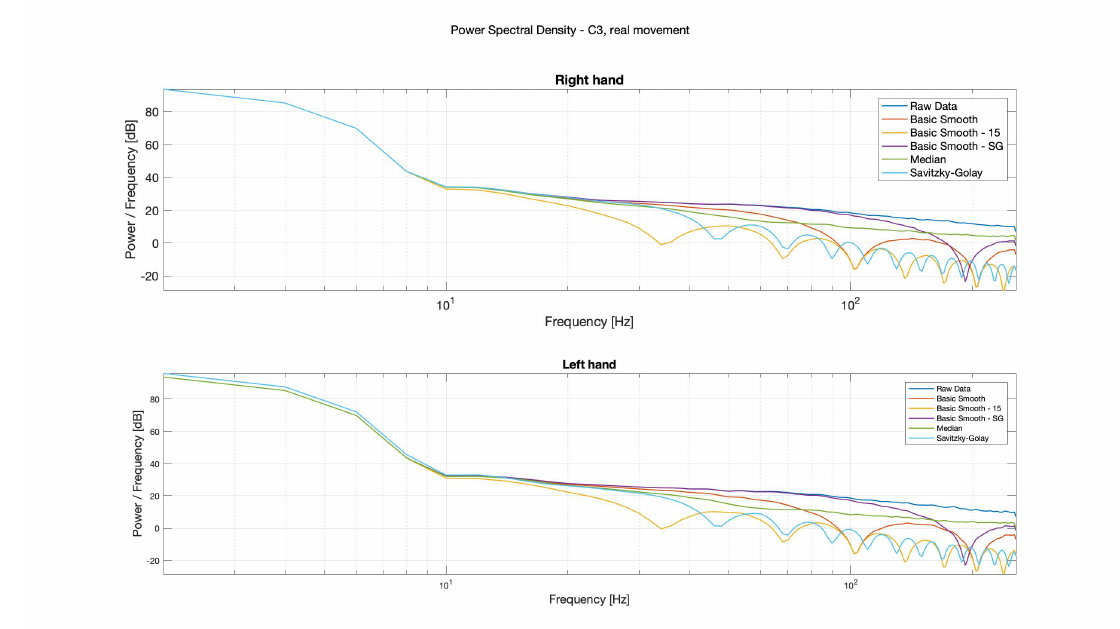
Figure 14. PSD—Bode plots, C3, real movement, right ( top ) and left ( bottom )